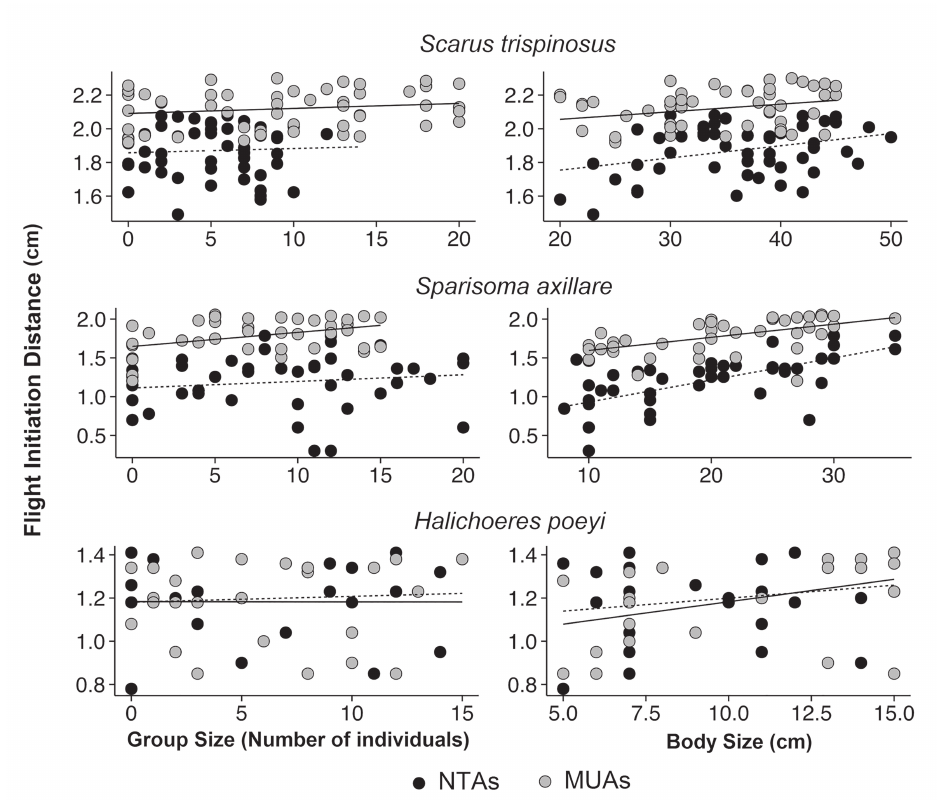
Fig. 4. Relationship between flight initiation distances (FID), group size and body size (continuous covariates) inside NTAs and MUAs (categorical factor). Black dots represent samples from no-take areas (NTAs); white dots represent samples from multiple-use areas (MUAs). The continuous line represents the best fit for MUAs data and the dotted line that for NTAs